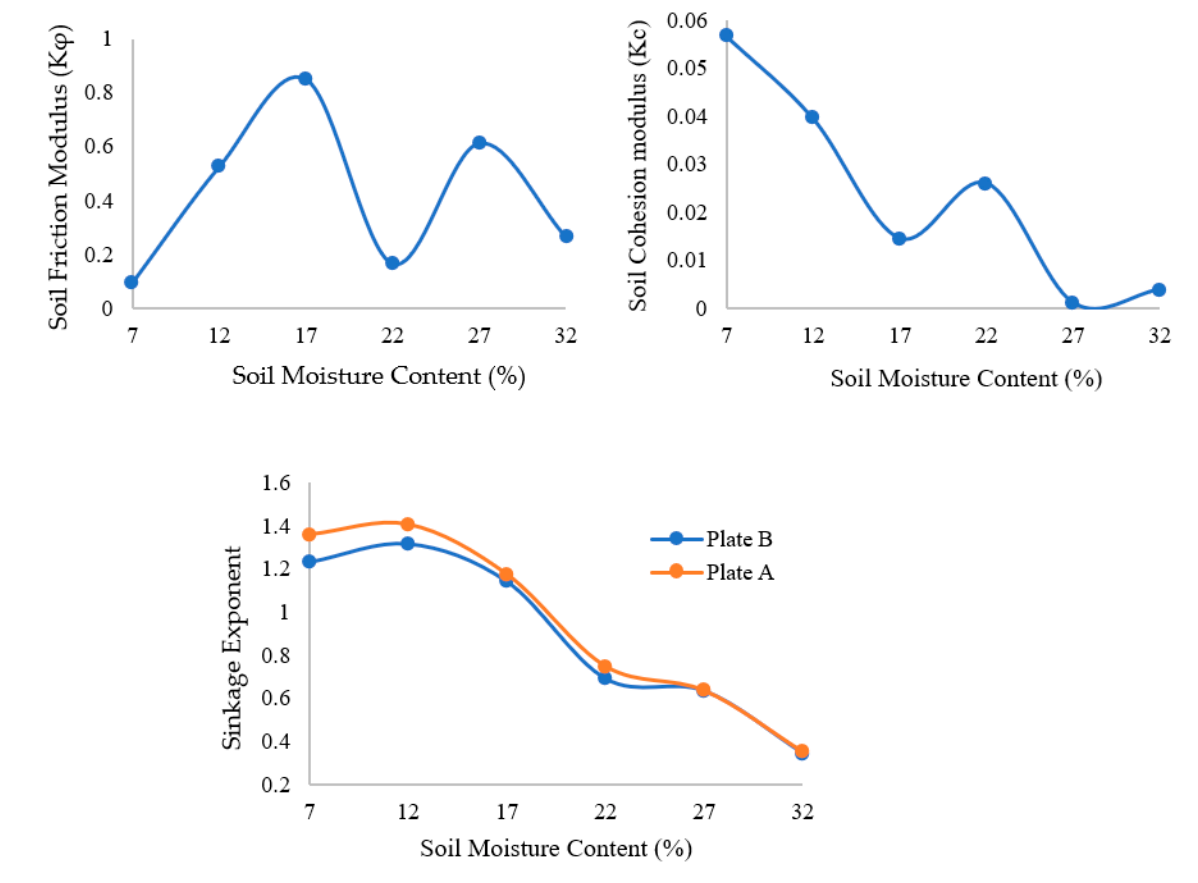
Figure 16. Parameters of Bekker’s pressure sinkage model.